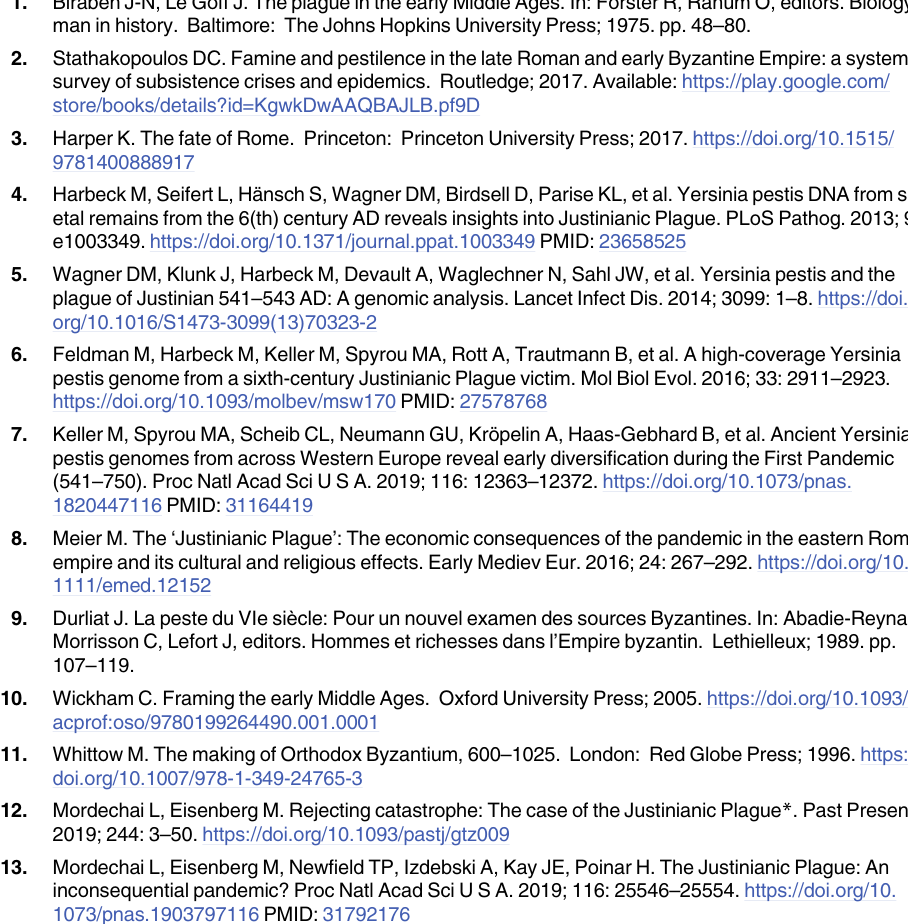
S2 Table. Summary of model output for each model type with rat to human ratio of 2:1. Outcomes include detectable outbreak duration, maximum mortality rate per day, and